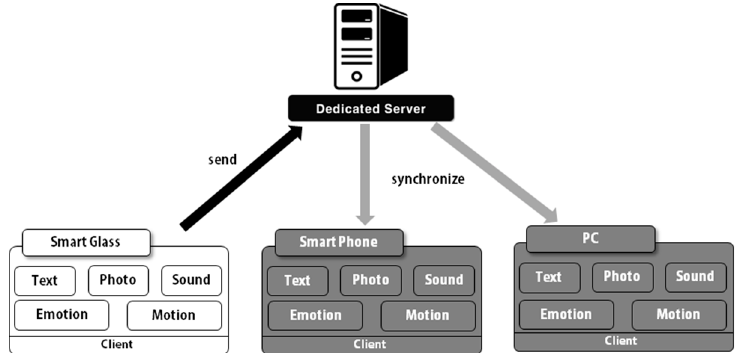
Figure 4. Process of synchronization by dedicated server (black arrow: transmission messages to server from client, gray arrows: print messages received from server on client screen).